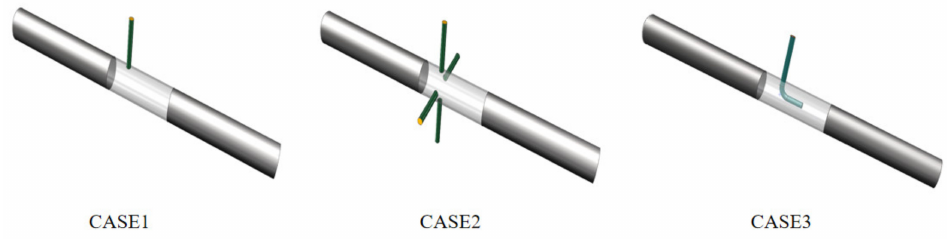
Figure 2. Particle injection